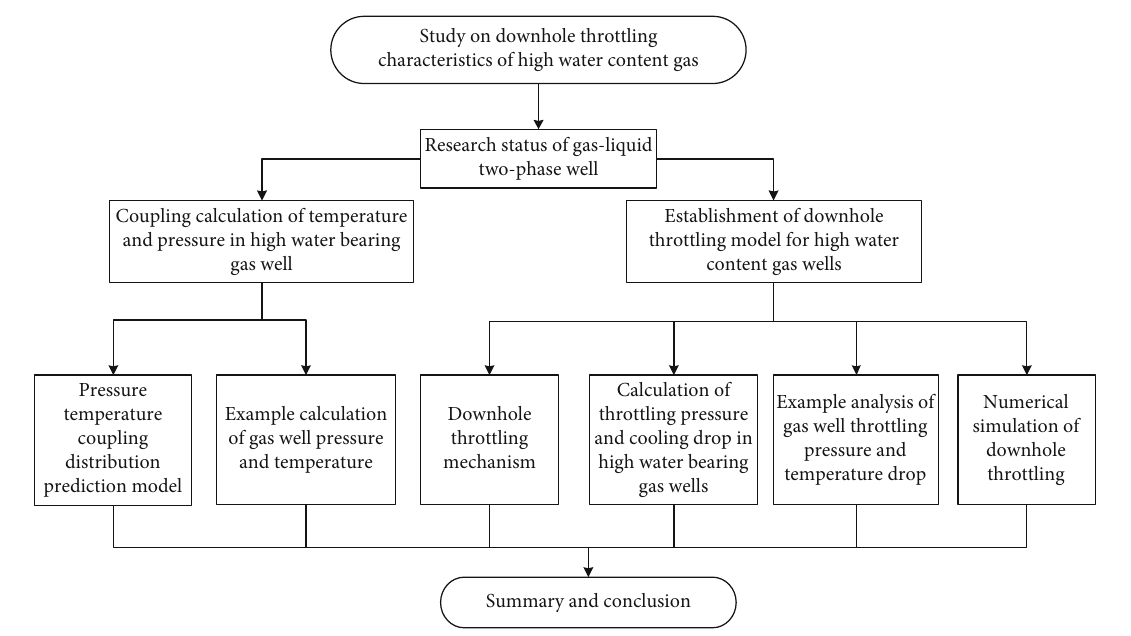
Figure 1: Technical fl